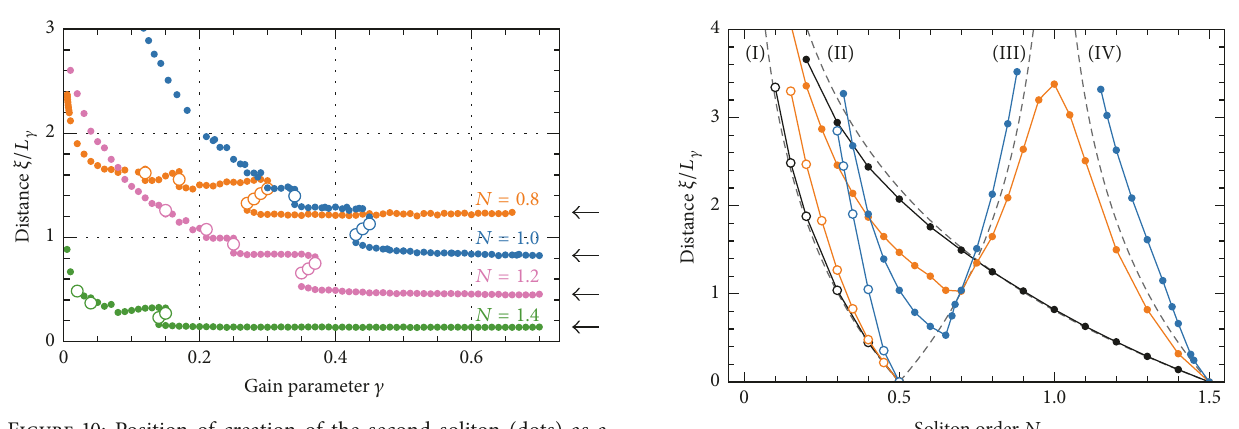
Figure 10: Position of creation of the second soliton (dots) as a function of gain parameter 𝛾 , for several initial soliton orders 𝑁 . Open circles: disappearance of the second soliton; see text. Distance is normalized to 𝐿 𝛾 = 1/𝛾 . Arrows mark distances as predicted by (21).